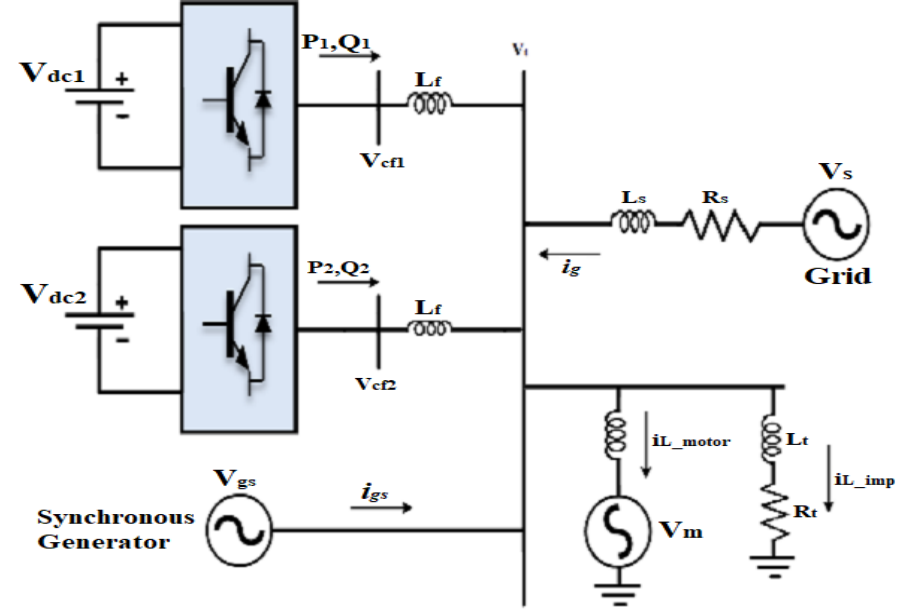
Figure 1. Microgrid with distributed generators and electrical loads.